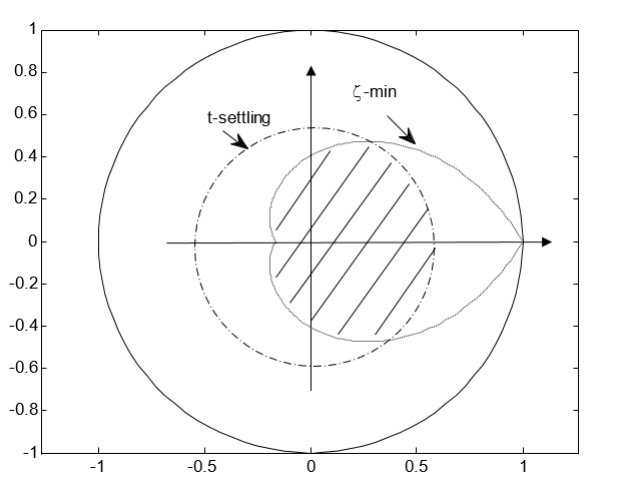
Figure 2. Closed-loop poles of the system, where the hatched area indicates the desired region (not to scale).